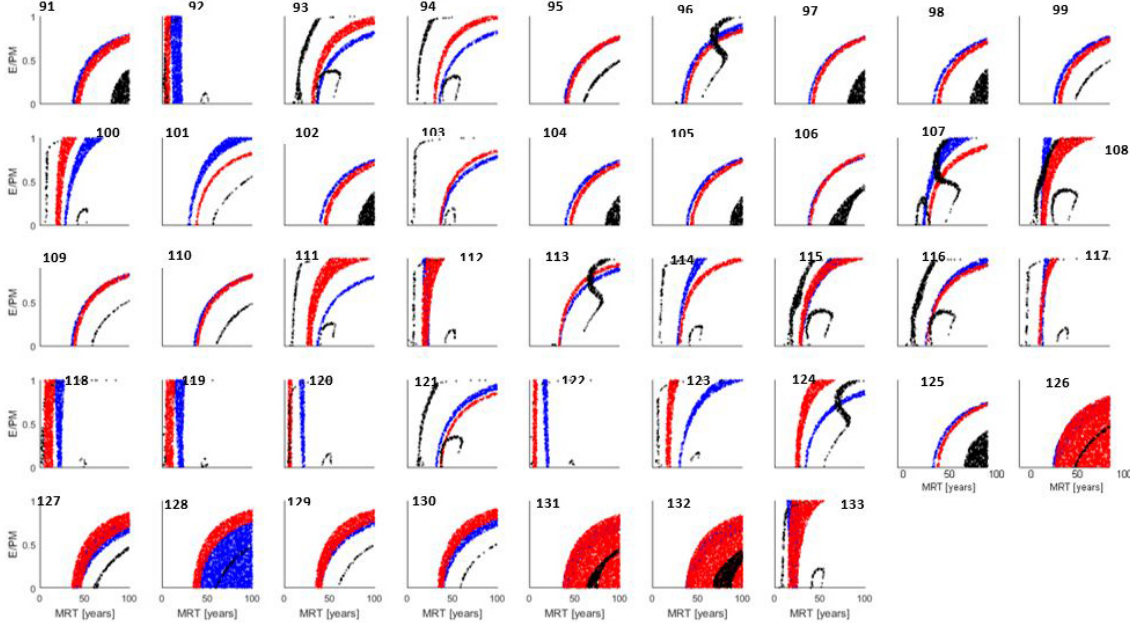
Figure A3. Behavioural age information (MRT and E / PM) inferred from SF 6 (red), tritium (black) and Halon-1301 (blue) for sites 91 to 133.